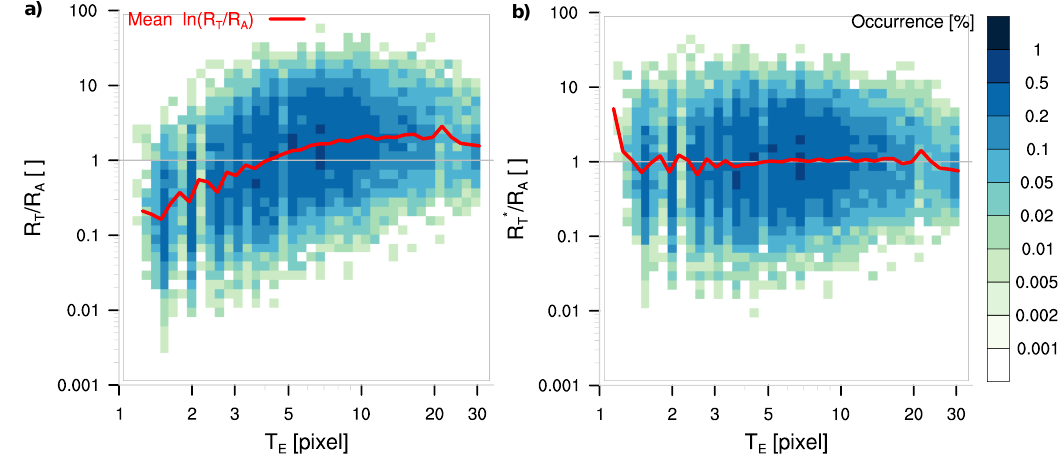
Figure 4. ( a ) 2D-histogram with relative occurrence (%) shown as colors of the rain-rate ratio R T a function of the along-track average rain event duration T E for uncorrected R T ; and ( b ) corrected R ∗ for C A >2% using Equation (2). Red lines mark the mean of ln ( R T highlight T E for which R A equals R T or R ∗